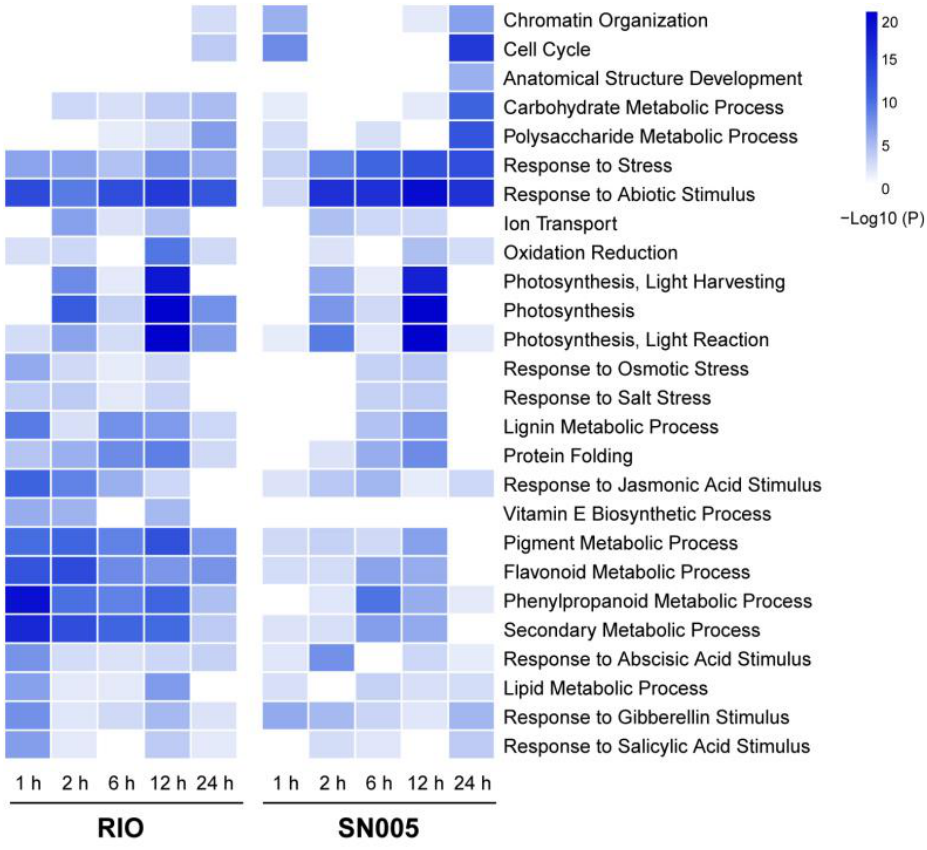
Figure 3. Significantly enriched GO terms of DEGs at each time point in the tolerant line RIO and the sensitive line SN005. The color of heatmap cells represents the log-transformed p value of GO enrichment analysis.